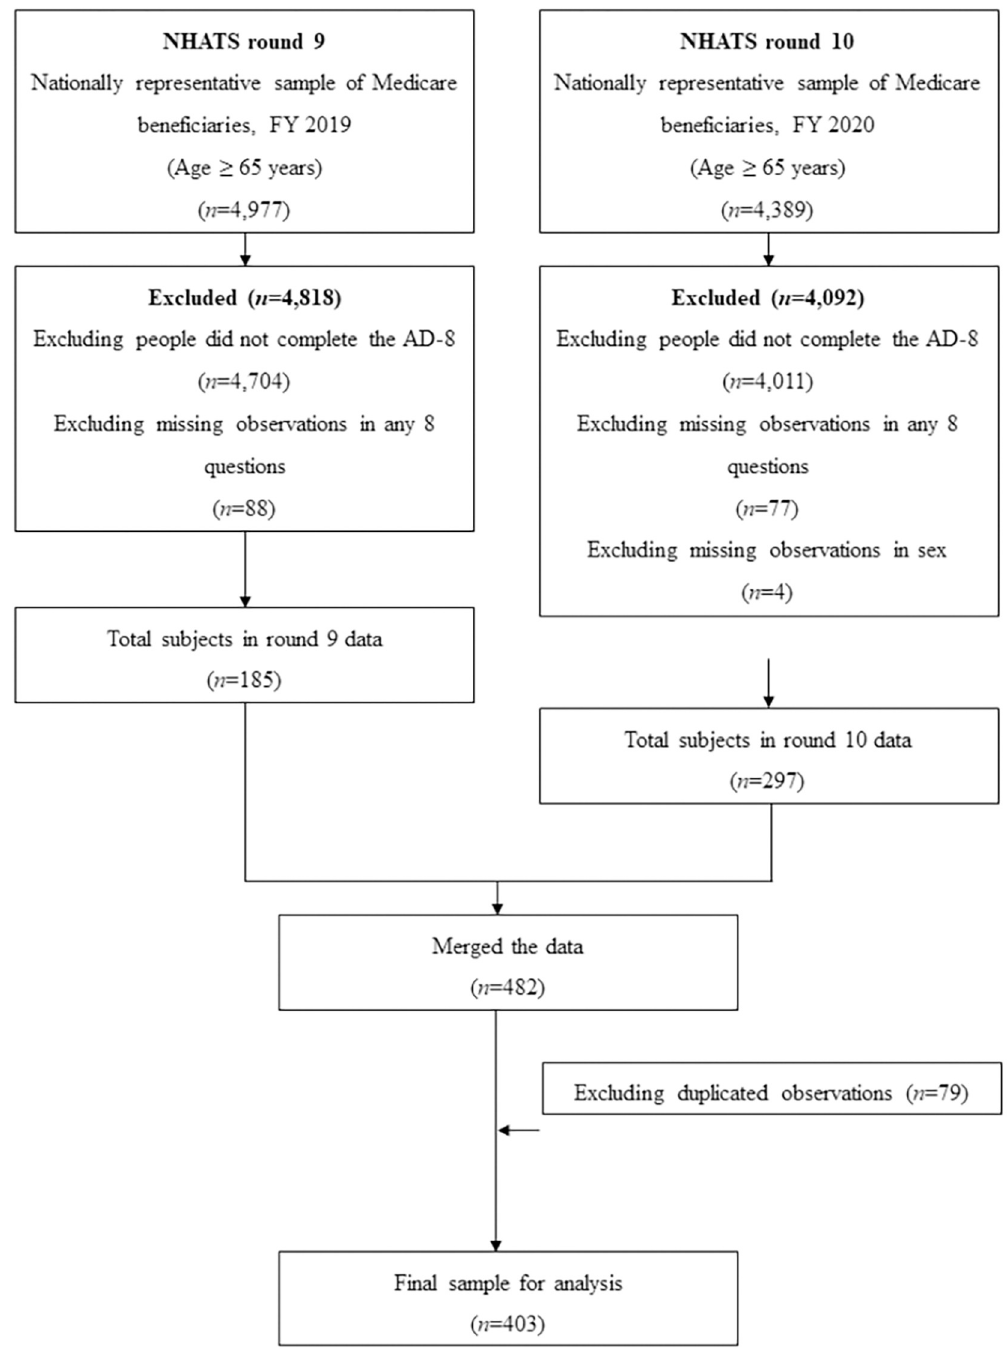
Fig 1. Cohort selection flow